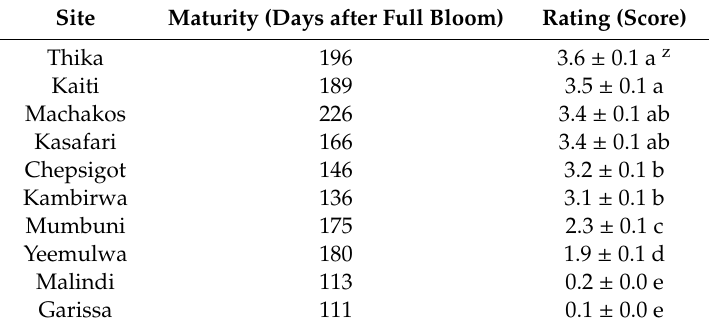
Table 6. Russeting of ‘Apple’ Mango at ten di ff erent sites across Kenya. Russeting was quantified using a five-score rating scheme: score 0: 0% of the fruit surface area russeted; score 1: 1–10% russeted area; score 2: 11–25% russeted area; score 3: 26–50% russeted area; and score 4: 51–100% russeted area.